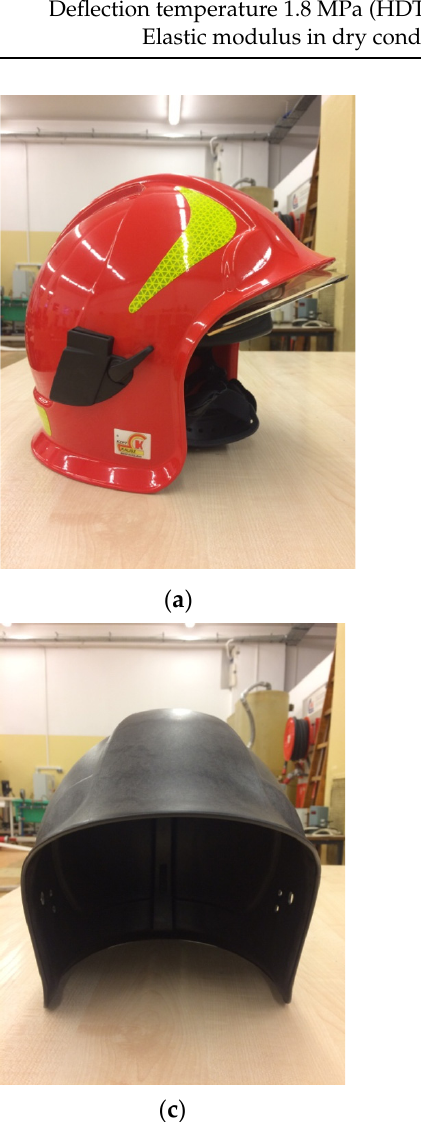
Figure 1. Firefighting helmet ( a ) and helmet shell ( b , c ) made of Ultramid (PA66-GF25FR) by injec- tion molding. Table 2. Technical parameters affecting a firefighter